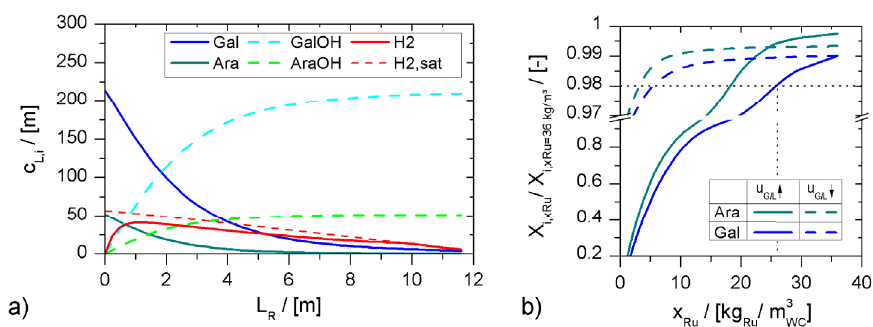
Figure 9. ( a ) Axial concentration profiles of all components in the liquid phase within the particle-packed minichannel reactor at 𝑢 (cid:3013),(cid:3046) = 1.46 m/s , 𝑢 (cid:3008),(cid:3046) = 0.22 m/s , 𝑥 (cid:3019)(cid:3048) = 26.0 kg (cid:2902)(cid:2931) /m (cid:2907)(cid:2887)(cid:2871) and ( b ) effect of reduced ruthenium content on the conversion of both reactants for high throughput (𝑢 (cid:3008)/(cid:3013) ↑ : 𝑢 (cid:3013),(cid:3046) = 1.46 m/s , 𝑢 (cid:3008),(cid:3046) = 0.22 m/s , 𝐿 (cid:3019) = 11.6 m ) and low throughput (𝑢 (cid:3008)/(cid:3013) ↓ : 𝑢 (cid:3013),(cid:3046) = 0.002 m/s , 𝑢 (cid:3008),(cid:3046) = 0.004 m/s , 𝐿 (cid:3019) = 2.49 m ).